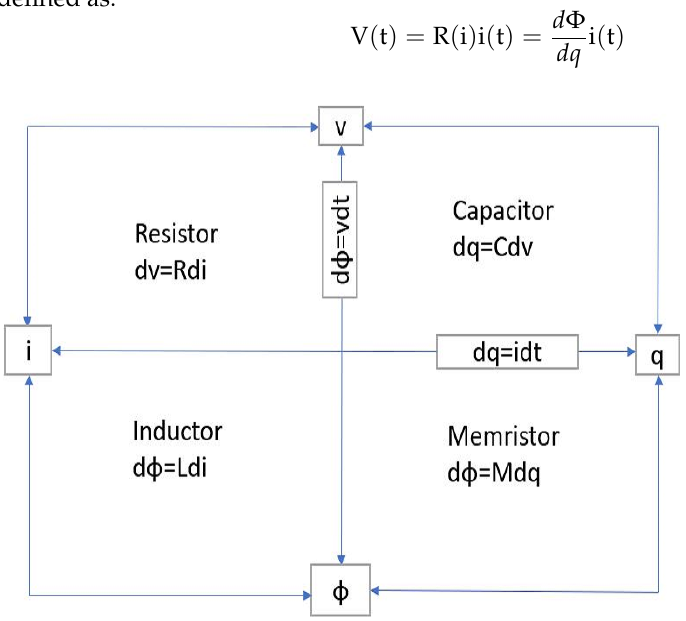
Figure 1. The memristor comprises four fundamental passive electrical